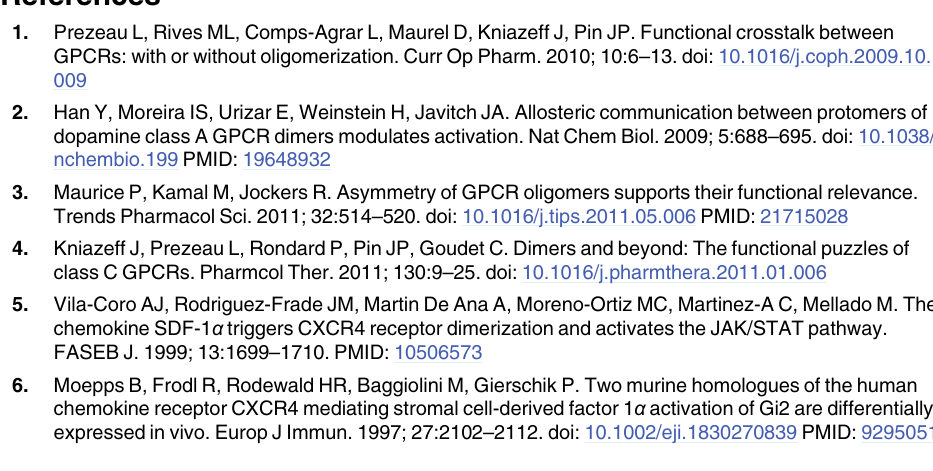
S2 Table. Interconversions between different dimer interfaces. Comparison of the number of initially formed and final CXCR4 dimer configurations in pure POPC, POPC at 10% choles- terol, and POPC at 30% cholesterol content. Configurations marked by ‘ n ’ did not belong to any of the seven defined dimer configurations (labels A through G ). Additionally, the total number of respective dimer configurations at the end of the microsecond association simula- tions is provided. In most of the simulations, the initially formed dimer configurations were stable, i.e. remained unchanged on the microsecond